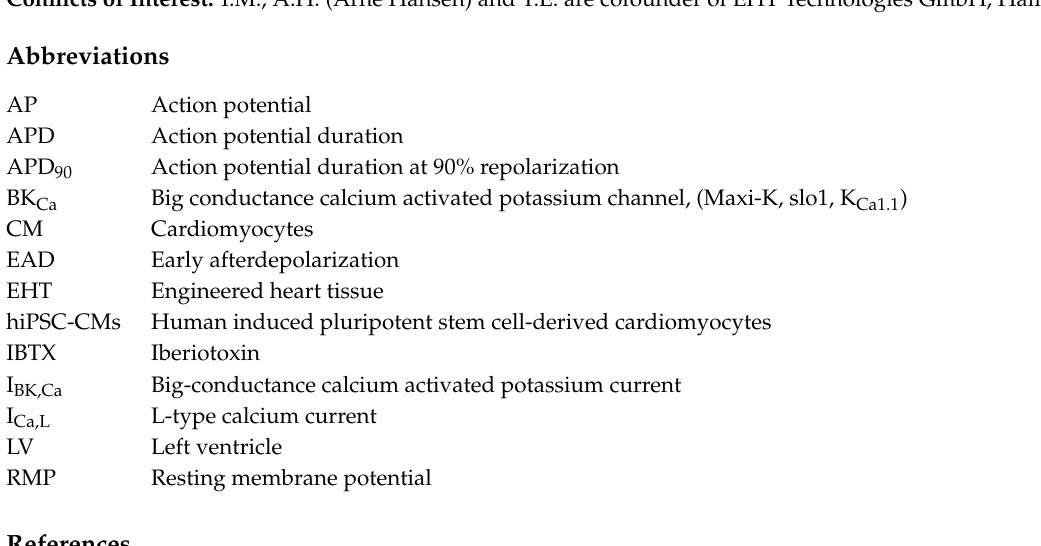
Figure S1: Outward currents in iCell human induced pluripotent stem cell-derived cardiomyocytes (hiPSC-CMs) and the e ff ect of iberiotoxin (IBTX) and Figure S2: Cardiomyocyte content analyzed by flow cytometry. Figure S3: Karyotype of hiPS-cells. Figure S4: RNA sequencing of BK related genes in hiPSC-CMs. Figure S5: Immunoflurorescence analysis of BK in